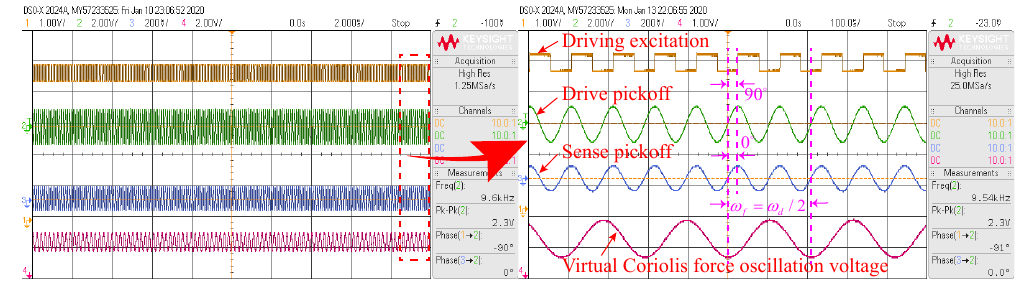
Figure 12. Phase relationship between signals under mode-matching steady state